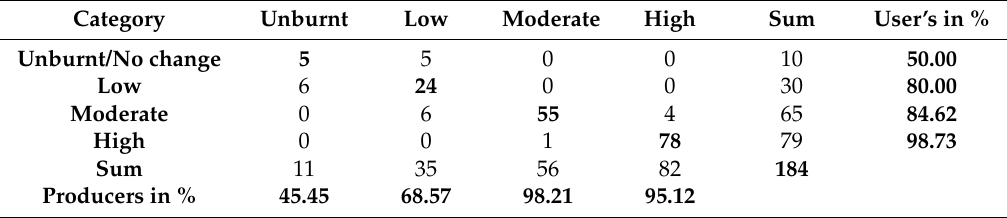
Table 3. Error Matrix of dNBR derived data 1 .